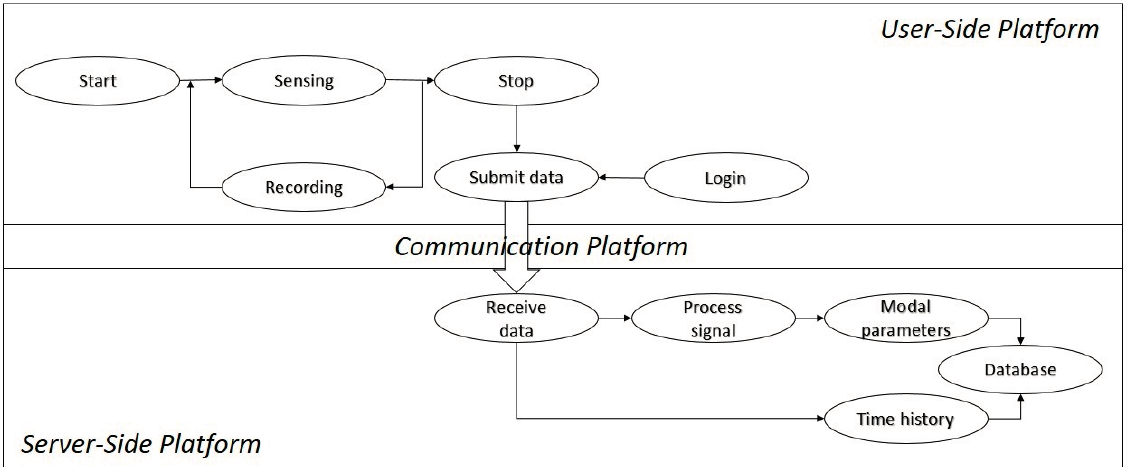
Figure 1. Integration scheme of system